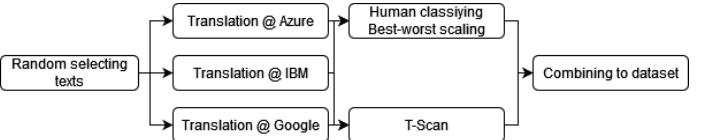
Figure 2. Dataset creation. First selecting the sentences, second translating the sentences from English to Dutch, third a human best-worst scale rating, fourth putting the texts into T-Scan and last combining the translations, T-Scan output and best-worst scale into one dataset.